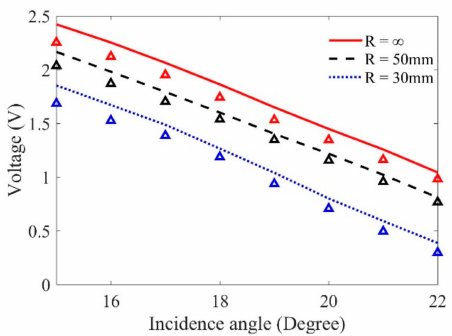
Figure 12. Comparison of wave magnitude results between the predictions and measurement using mode-converted shear waves when the curvatures and incidence angle